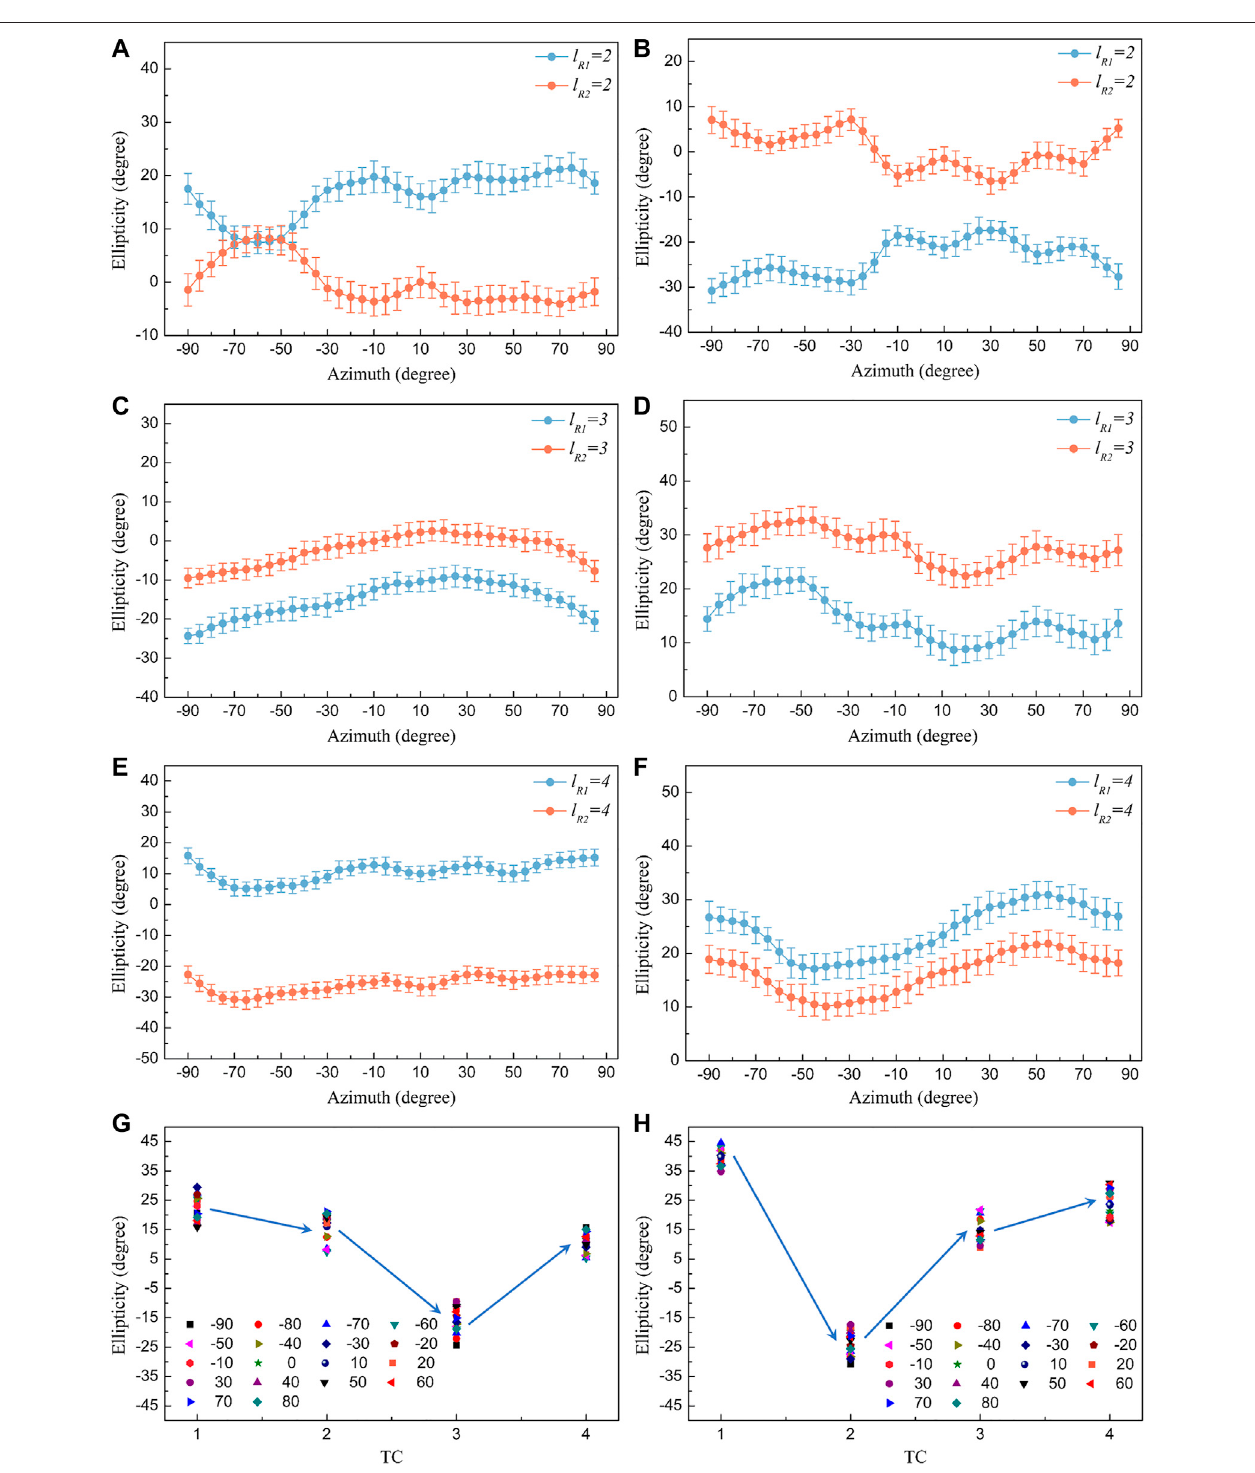
FIGURE5| Undertheeffectofthespatialdegreeoffreedomofrecordinglightonpolarizationmanipulation,theellipticityofthe (A) − 1 st and (B) +1 st orderdiffraction lightfromOPHG ( l R1 =2) and OPHG ( l R2 =2) isregulated symmetrically when α p changesfrom − 90 ° to90 ° at an intervalof5 ° .With TCincreasing,theellipticitysymmetry breakingoccursandtheellipticityofthe (C) − 1 st and (D) +1 st diffractionordersfromOPHGs( l R1 =3and l R2 =3)variesinasimilartrend.Synchronousellipticitymodulation ofthe (E) − 1 st and (F) +1 st orderdiffractionbeamsfromOPHG( l R1 =4)andOPHG( l R2 =4).OAM-controlledellipticityvariationofthe (G) − 1 st and (H) +1 st diffraction orders from OPHGs ( l R1 = 1 – 4) as TC increases from 1 to